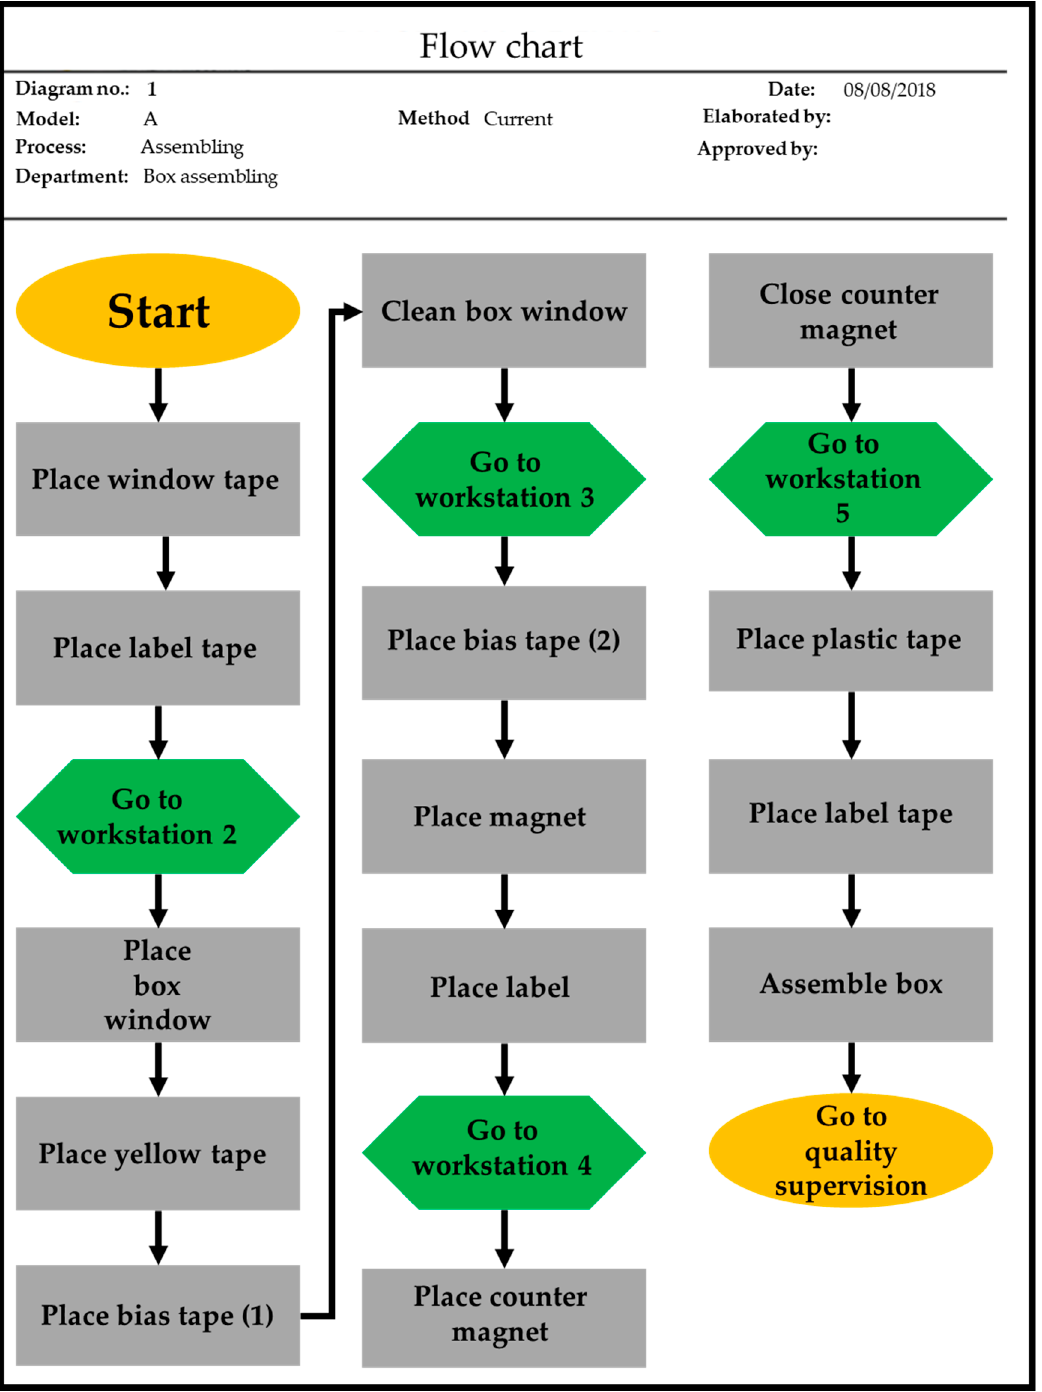
Figure 2. Flow chart of the corporation current production process.